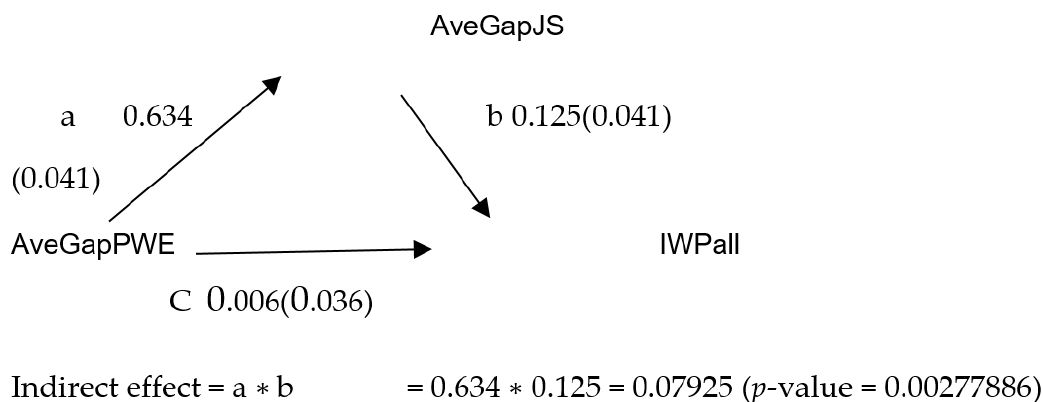
Figure 3. Mediating role of JSS in AveGapPWE and IWP.